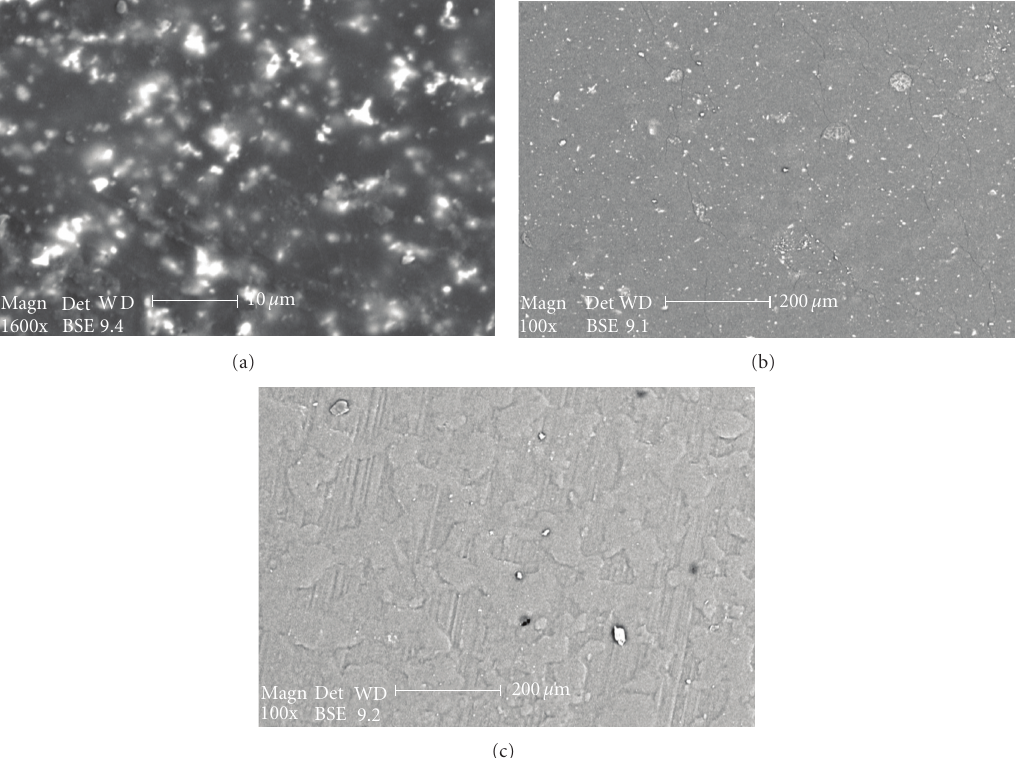
Figure 3: (a) SEM micrograph of sample code, Z 5 . (b) SEM micrograph of sample code, nZ 5 . (c) SEM micrograph of sample code, nZ 7